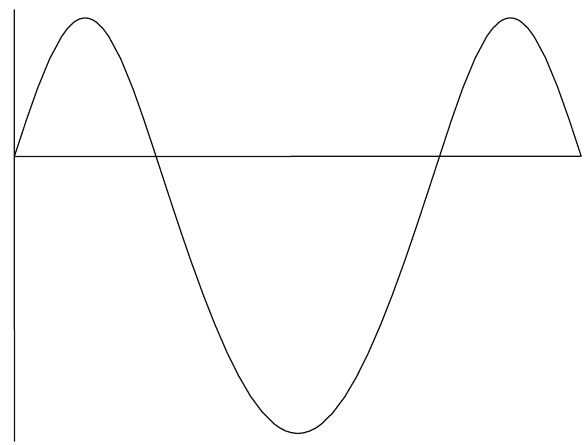
Figure 2: Eigenfunction for (cid:3) α,β (cid:5) ∈ C 1